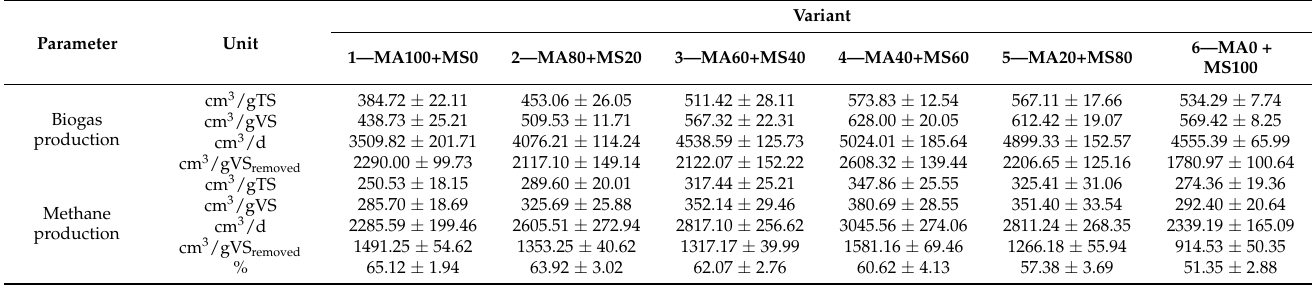
Table 3. Performance of microalgal biomass co-digestion with giant miscanthus